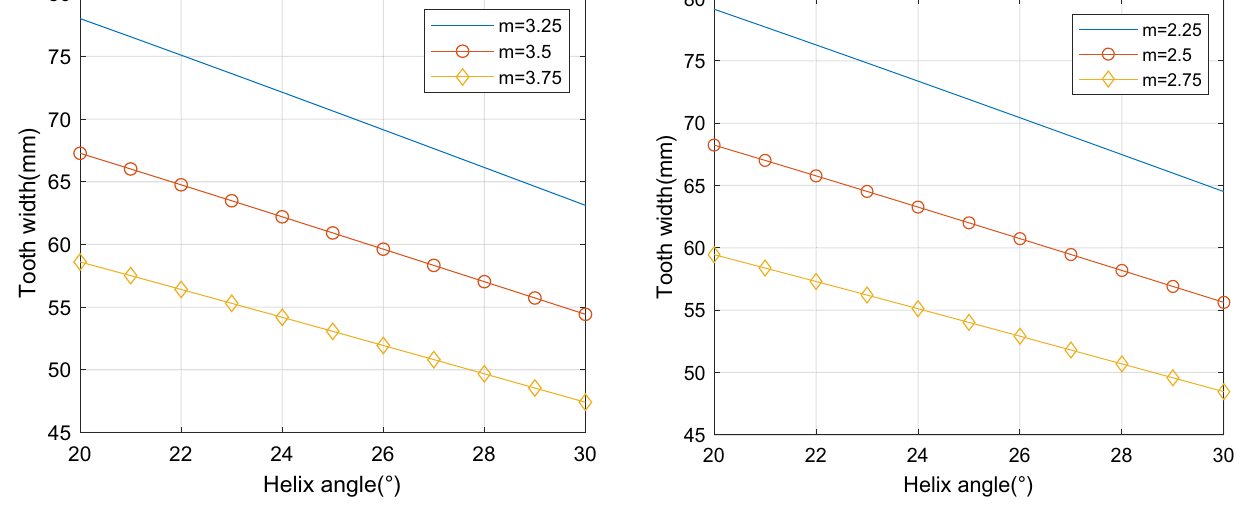
Fig. 18 Tooth width value of different modulus and helix angle at equal bending strength of the teeth and pressure angle of